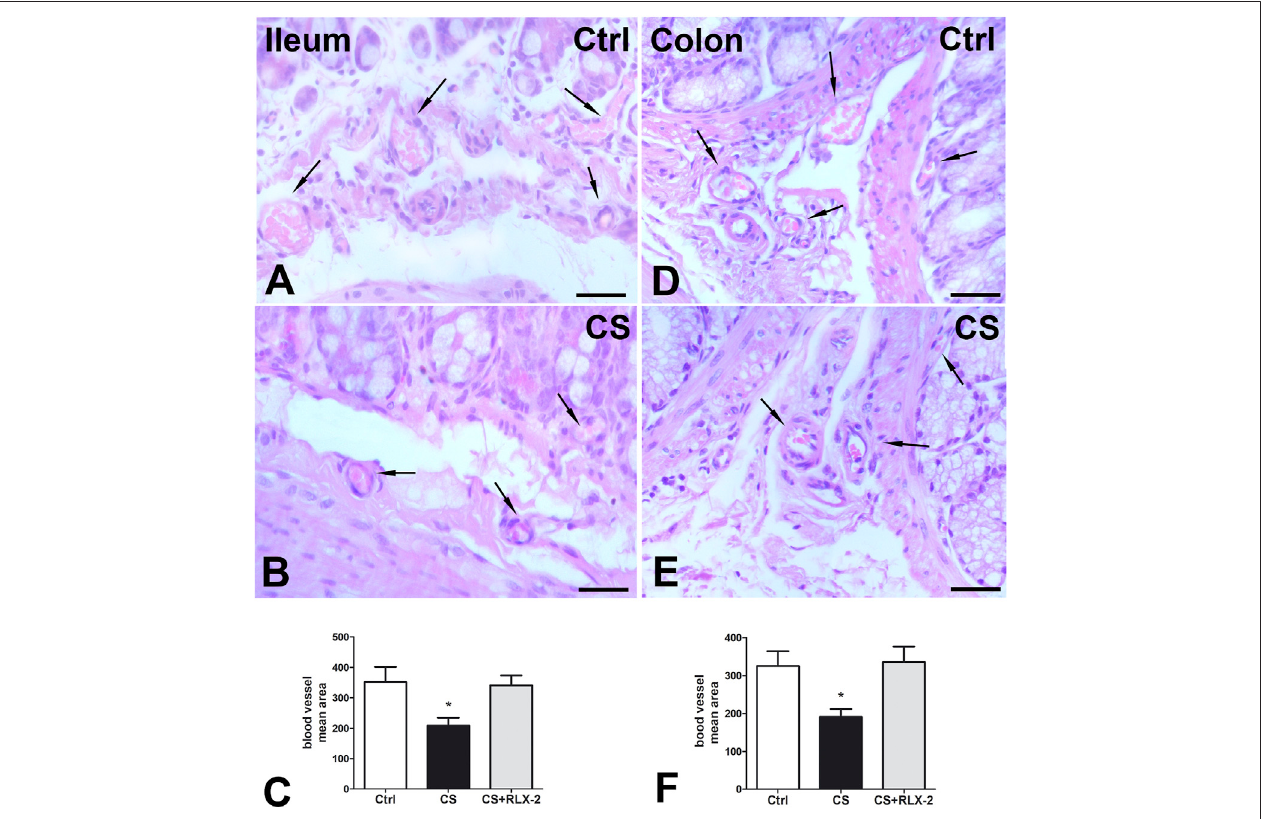
FIGURE2| Hematoxylin – eosin(H&E)stainingandbloodvesselareachanges. (A,B) Ileum. (D,E) Colon.Representativeimagesofthesubmucosaandthemucosa of control (A,D) and cigarette smoke (CS)-exposed (B, E) guinea pigs showing several blood vessels containing erythrocytes ( arrows ). Quantitation of the blood vessel area in the ileum (C) and colon (F) demonstrated a signi fi cant decrease in CS-exposed animals. Relaxin-2 (RLX-2), chronically administered in CS-exposed animals, prevented this decrease (C,F) . Bar , 25 μ m (A,B,D,E) . * p <